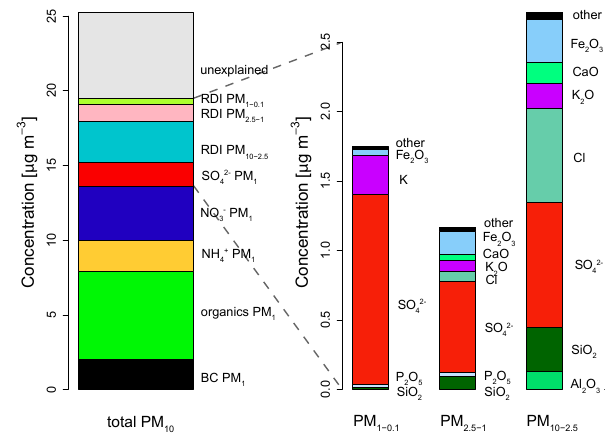
Fig. 3. Bar charts showing the average composition of total mea- sured PM 10 in the period of simultaneous RDI, AMS and BC (PM 1 ) measurements: the left side shows all identified components of the total PM 10 mass concentration, leaving an unexplained fraction of about 25%. Shown are BC (Aethalometer, PM 1 ), the components identified by the AMS (organics, NH + , NO − , SO 2 − ) and the sum 4 3 4 of trace elements for each size range (masses are extrapolated to the corresponding oxides, except for K in the fine mode and Cl in the coarse mode). The right side shows the elemental composi- tion, extrapolated to the oxides, for the three size ranges (PM 10 − 2 . 5 , PM 2 . 5 − 1 and PM 1 − 0 . 1 ) as determined by the RDI and SO 2 − as de- 4 termined by the AMS for PM 1 − 0 . 1